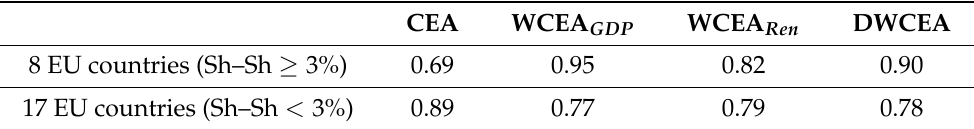
Table 5. Pearson correlation coefficients for CO 2 allocation vectors provided by the four allocation rules considered in this paper over the interval 2010–2014, and for two groups of countries (groups are based on the Sh–Sh power index, cut-off 3%).